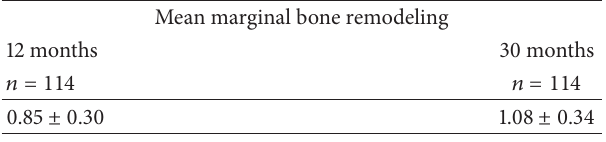
Table 2: Peri-implant mean marginal bone remodeling ( 𝑛 : number of implants).